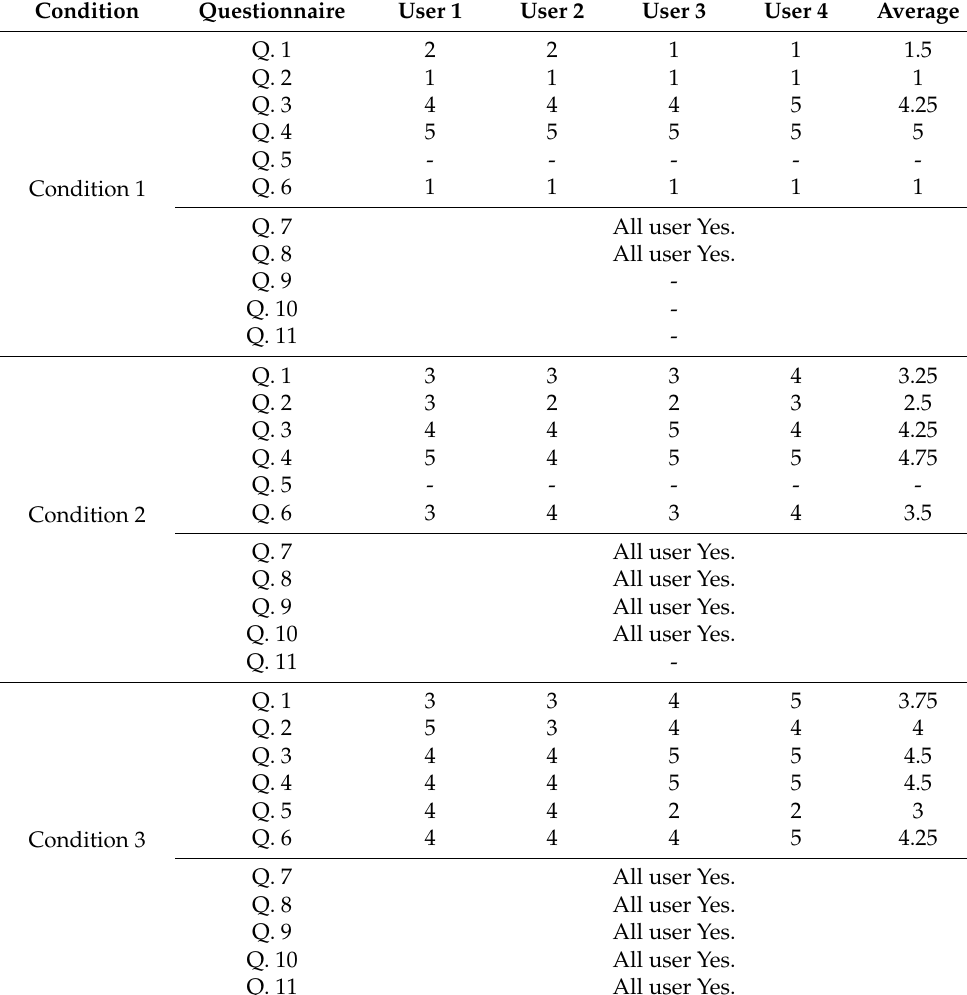
Table 11. Results of subjective